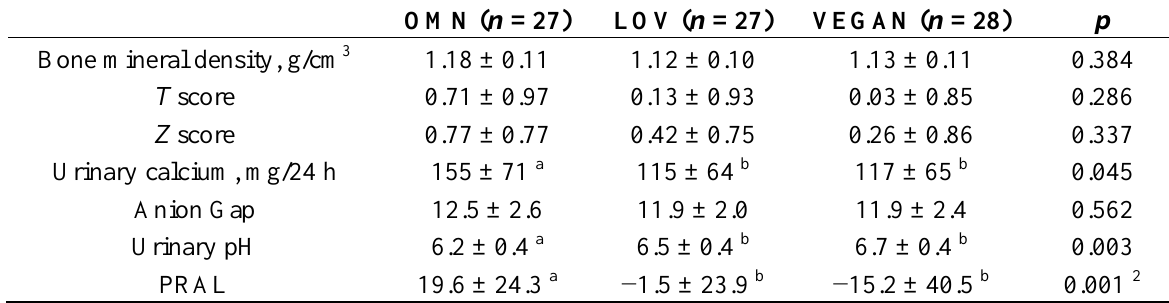
Table 2. Bone mineral density and urinary measures by diet group (omnivorous, OMN; lacto-ovo vegetarian, LOV; vegan, VEGAN) 1